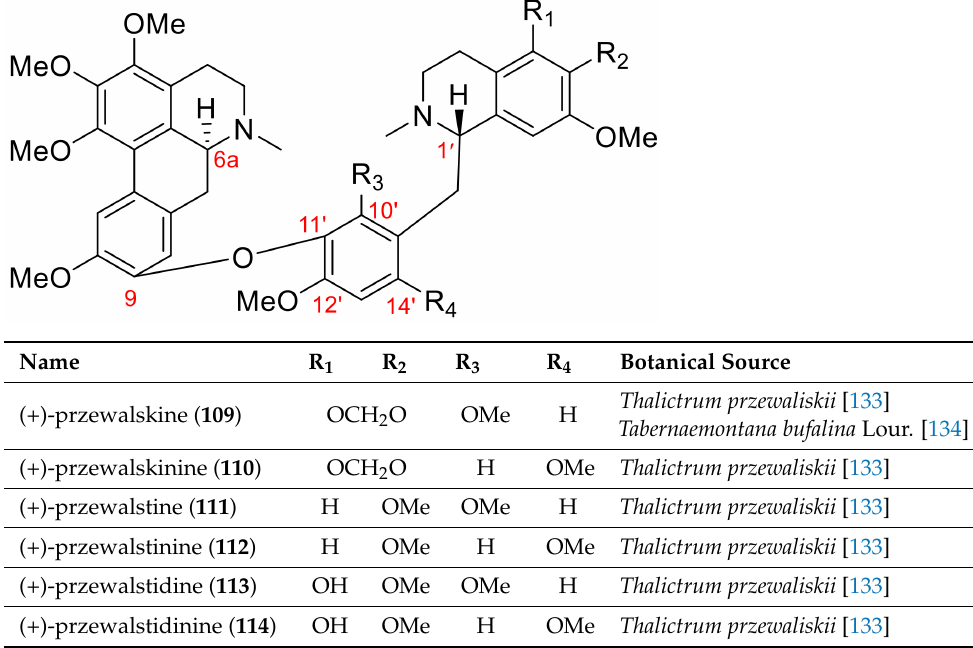
Table 13. Aporphine–benzylisoquinoline dimeric alkaloids belonging to a new type of